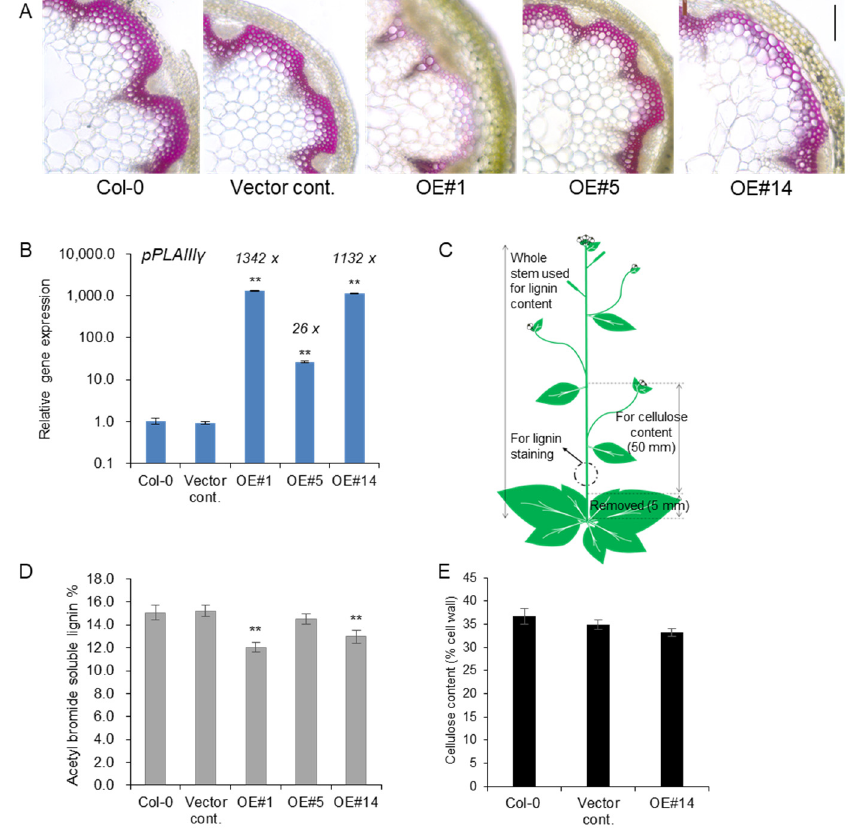
Figure 3. Lignin content was reduced in stem of pPLAIII γ OEs without altering cellulose content. ( A ) Phloroglucinol ‐ HCl staining and ( B ) transcript levels of pPLAIII γ in controls and OE lines ( C ) Arabidopsis image showing the parts used for lignin and cellulose analysis. ( D ) Total content of lignin by acetyl bromide method, and ( E ) quantification of cellulose content in 7 ‐ week ‐ old stems of controls and pPLAIII γ OE . Each data point represents the average ± SE of multiple independent replicates at p < 0.05 (*) and p < 0.01 (**), respectively. n = 3 (B), n = 4 (D), and n = 5 (E). 2.4. Lignin ‐ Specific Transcription Factors Are Downregulated in the Stem of pPLAIII γ OE Two key transcription factors, MYB58 and MYB63 , involved in lignin biosynthesis